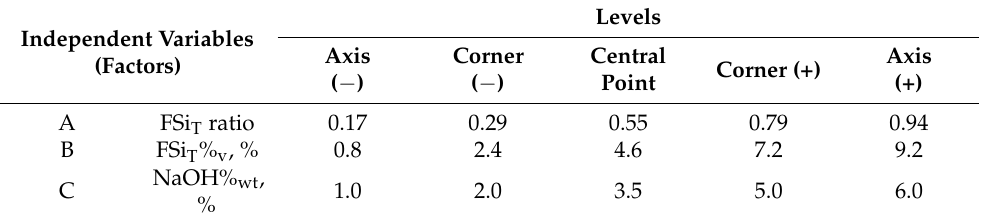
Table 2. Factors and levels used in the design of the experiments and statistical analysis of the modification